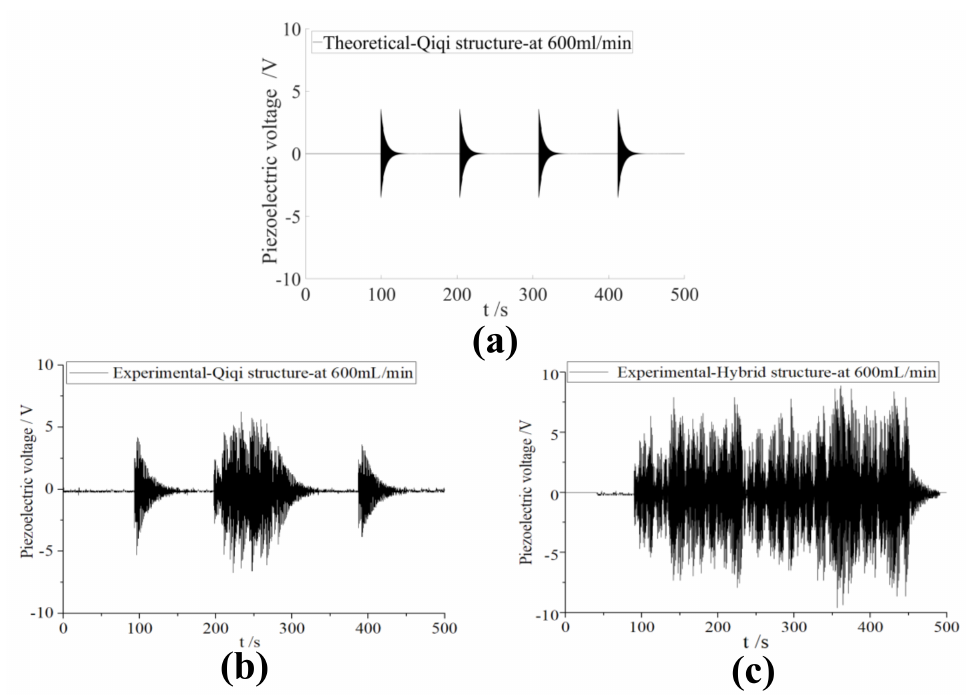
Figure 9. Performance comparison between the Qiqi structure and the proposed hybrid structure: ( a ) theoretical voltage of the Qiqi structure at 600 mL/min; ( b ) experimental voltage of the Qiqi structure at 600 mL/min; ( c ) experimental voltage of the hybrid Qiqi structure at 600